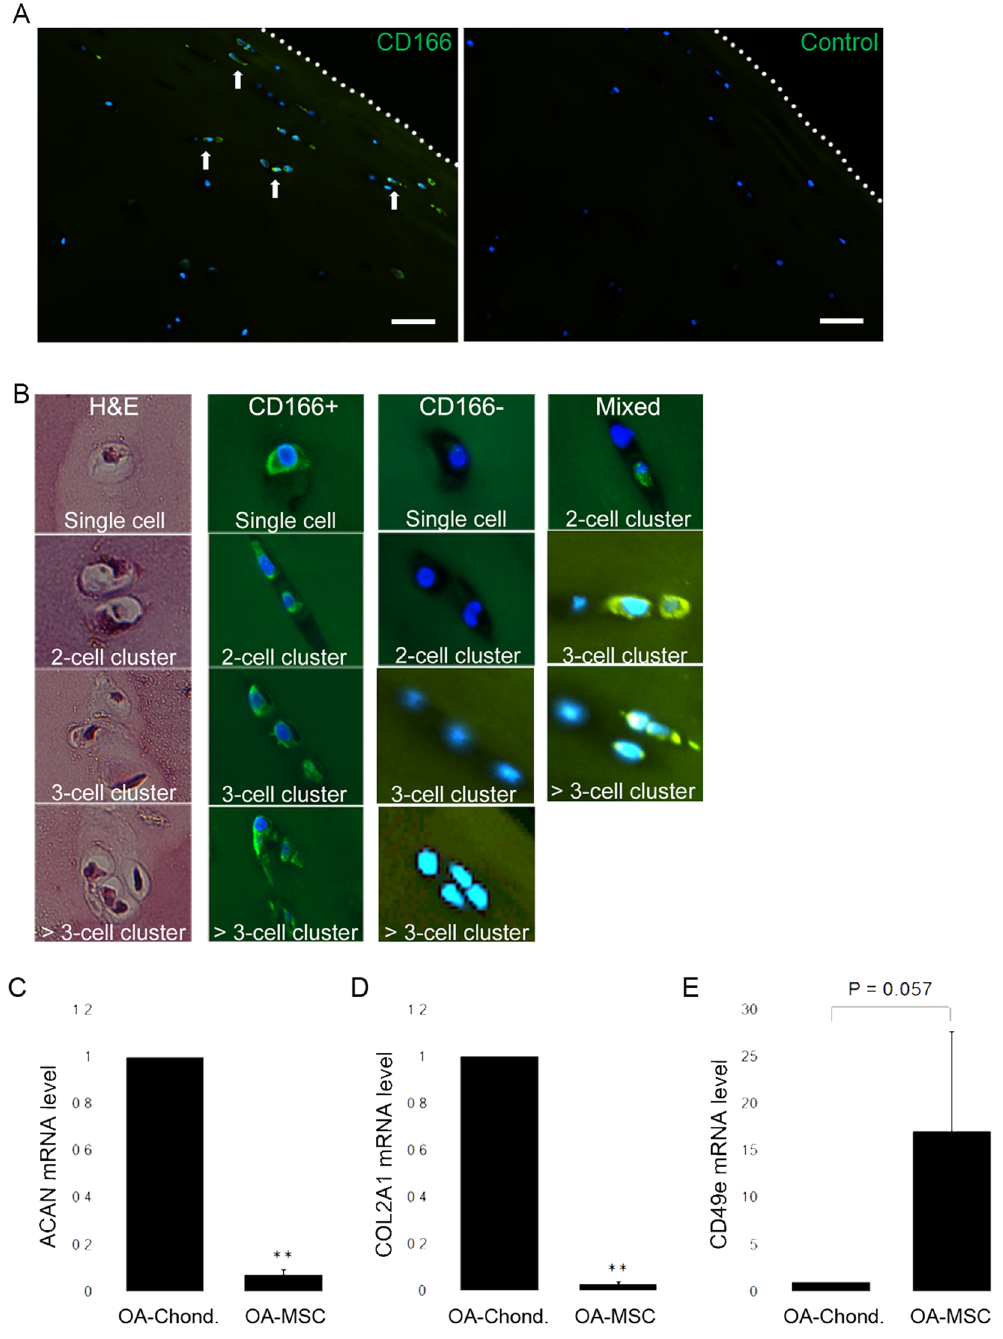
Figure 1. In situ analysis of primary OA cartilage derived mesenchymal stem cells and their gene expression. (A) Immunofluorescent staining of human OA cartilage sections stained with Dapi (blue) and an antibody against mesenchymal stem cell surface marker CD166 (green). White arrows indicate several positive staining events. The dotted line signifies the articular surface. Control section stained with Dapi and secondary antibody only. The dotted line signifies the articular surface. Scale bar represents 100 µ m. (B) H&E staining and Immunoflorescent staining of human OA cartilage sections with Dapi (blue) and CD166 antibody (green) shows representative single OA stem cells as well as stem cell clusters (Left four panels). A cell cluster was defined as multiple cells occupying the same chondron. OA chondrocytes and chondrocyte clusters are CD166 − (middle four panels). Clusters containing both OA chondrocytes and OA stem cells are labeled “mixed” and shown in the right most three panels. (C) Quantification of ACAN, (D) COL2A1 and (E) CD49e mRNA levels in CD166 + primary human OA cartilage stem cells, compared with CD166 − primary human OA chondrocytes. n ≥ 3. ** p ≤ 0.01, relative to CD166 − chondrocytes. Quantitative data are represented as mean ±